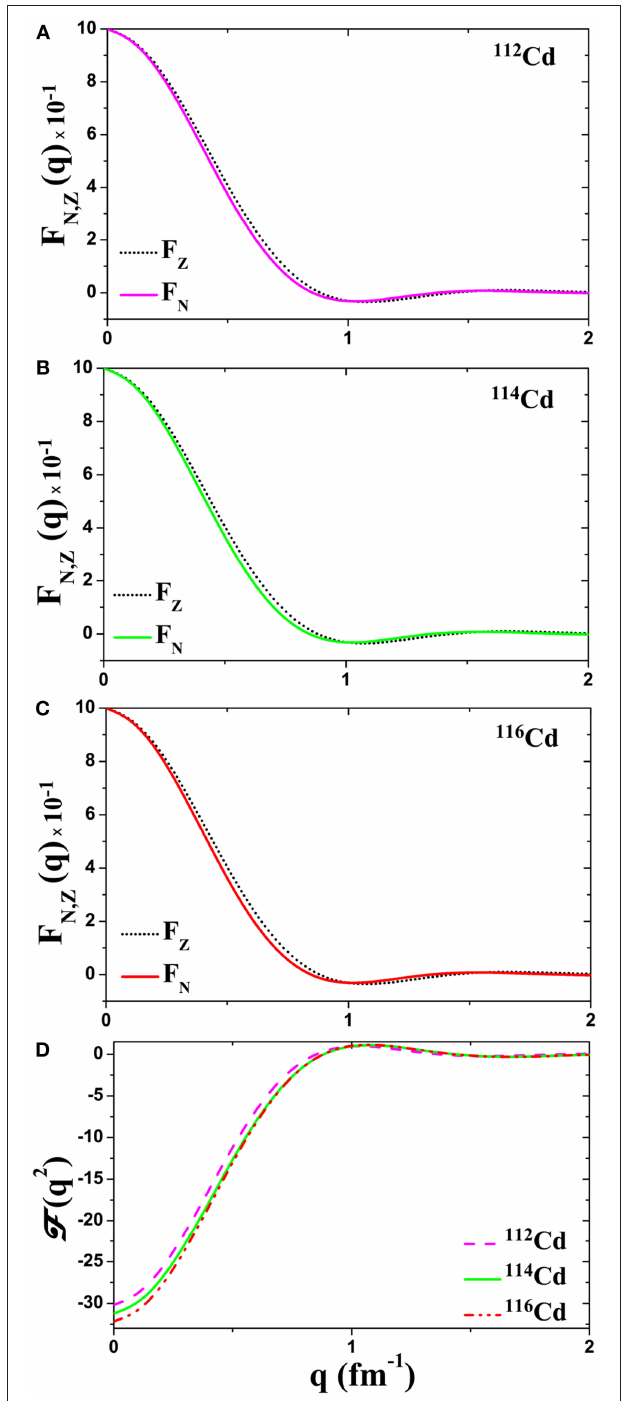
FIGURE 1 | Neutron and proton nuclear form factors F N , Z ( q 2 ) (A) for 114 Cd, (B) for 112 Cd, and (C) for 116 Cd isotopes. (D) The ground-state elastic nuclear form factor F ( q 2 ) for 112,114,116 Cd isotopes.